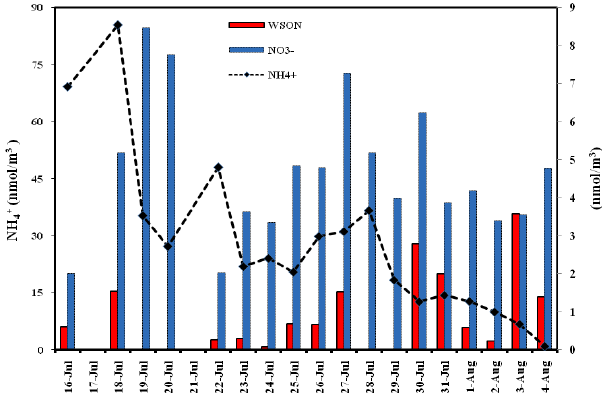
Figure 4. Temporal variation in nitrogen species concentration in fine particles ( D a < 2µm) over the tropical North Atlantic atmo-